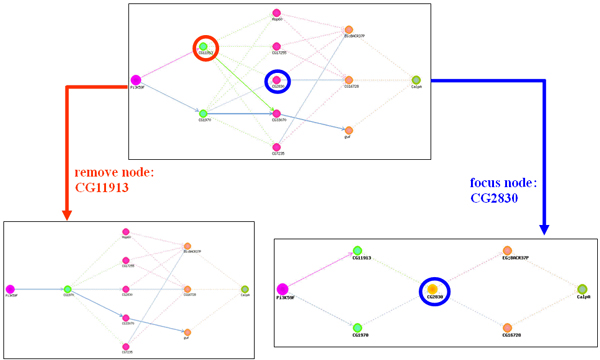
A snap of Ping-Pong search. A map of proteins involved in apoptosis generated by the ping-pong search. By clicking on the nodes or lines between two query proteins, the advanced option removed the related paths or confines the paths to the selected nodes or lines.